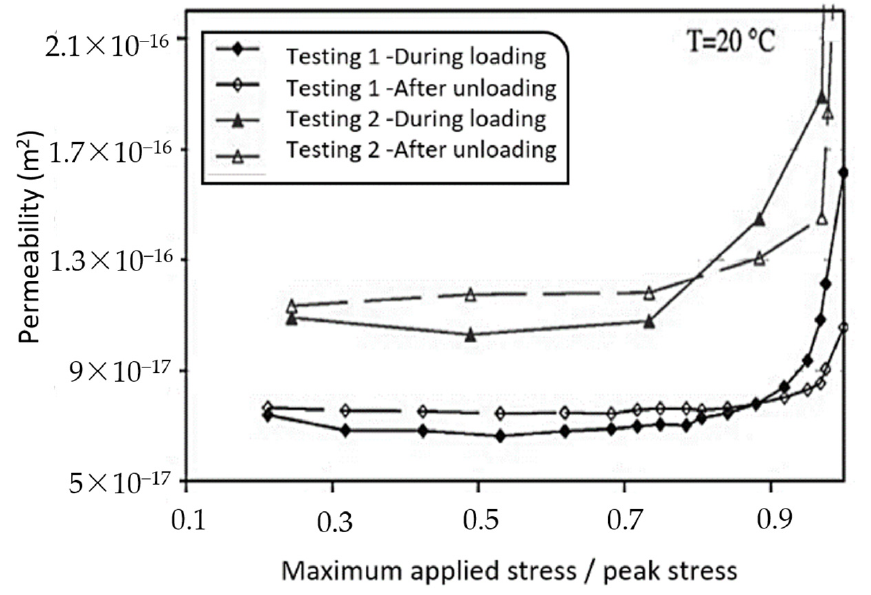
Figure 24. Permeability–applied stress relationship (Adapted with permission from reference [93]).